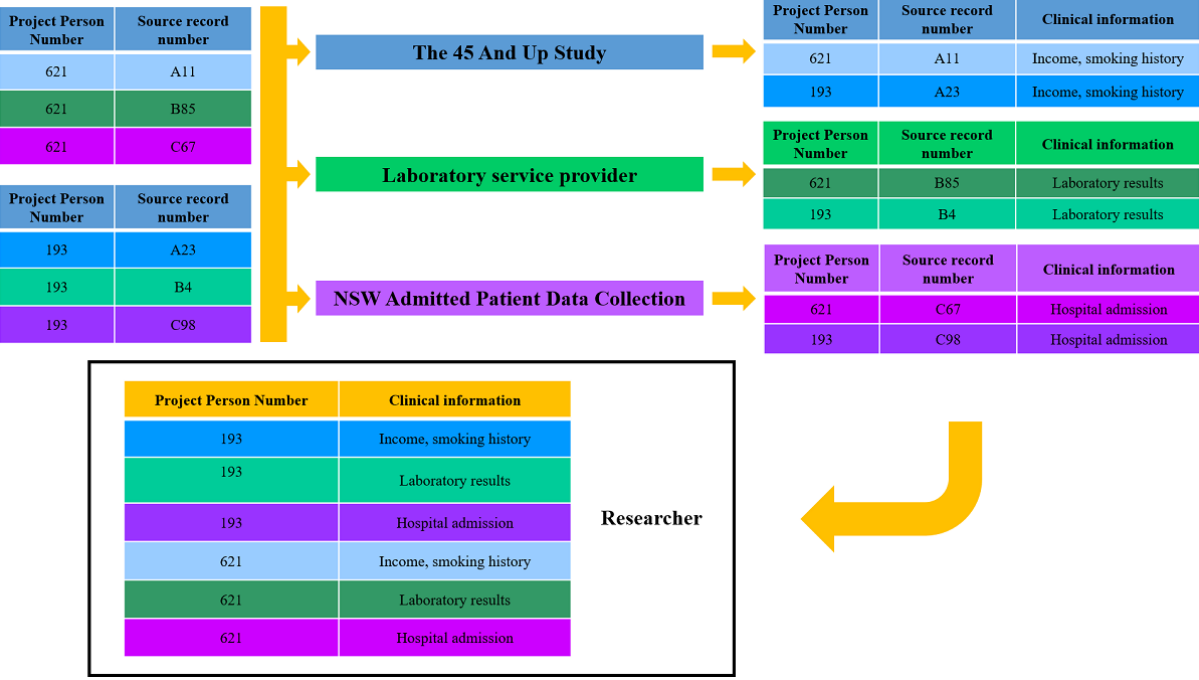
Figure 3. A schematic diagram of the linkage process: Stage 2. The Centre for Health Record Linkage (CHeReL) provides data custodians with the project-specific person number (PPN) for each individual, with all personal information removed. Data custodians use the PPN, together with their own record numbers, to extract the requested data and upload the data to Secure Unified Research